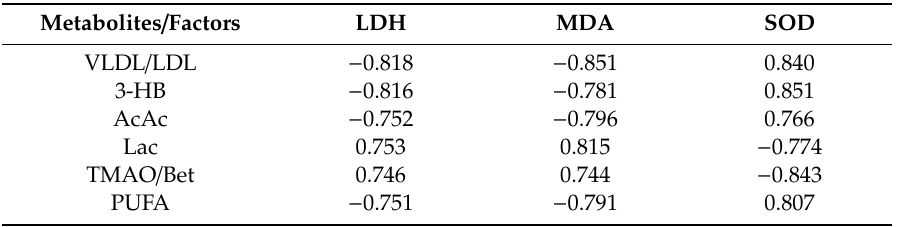
Table 4. Pearson correlation coe ffi cients between discriminatory metabolites and biochemical factors for the control group vs the model group in